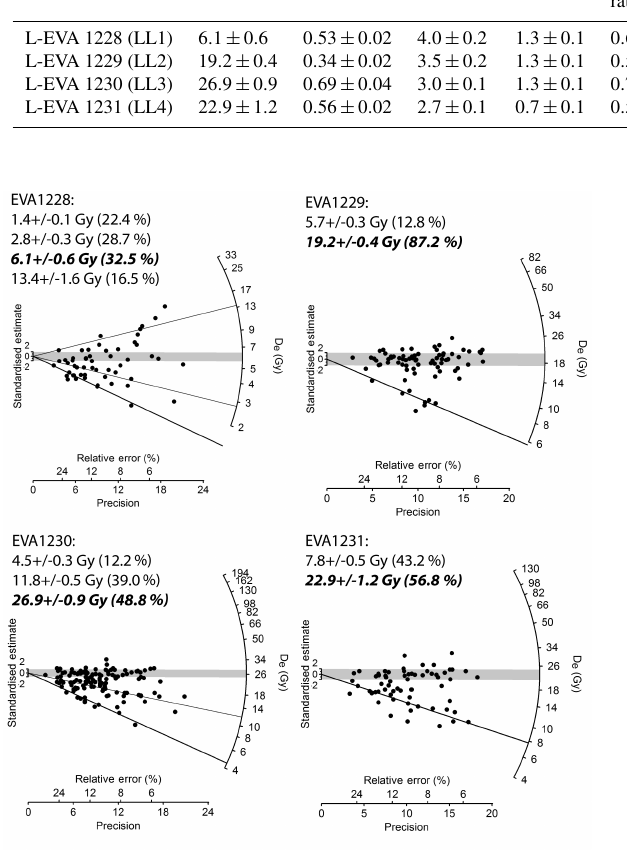
Figure 3. Equivalent-dose distributions for the LLL samples, illus- trated as radial plots. The shaded populations in each case represent the dominant age peaks; the lines illustrate the other identified pop-